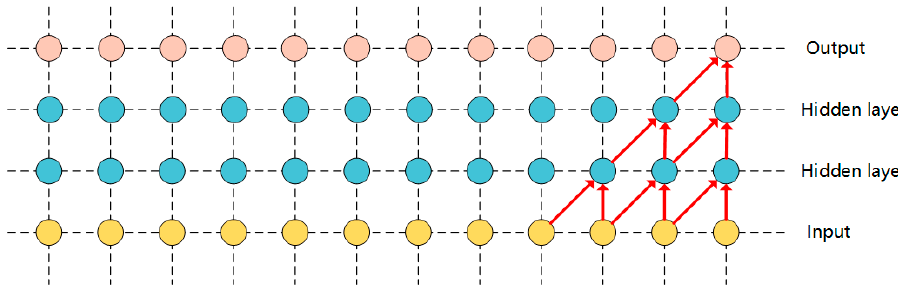
Appl. Sci. 2021 , 11 , x FOR PEER REVIEW Figure 4. Causal Convolution Model Structure. Figure 4. Causal Convolution Model Structure.